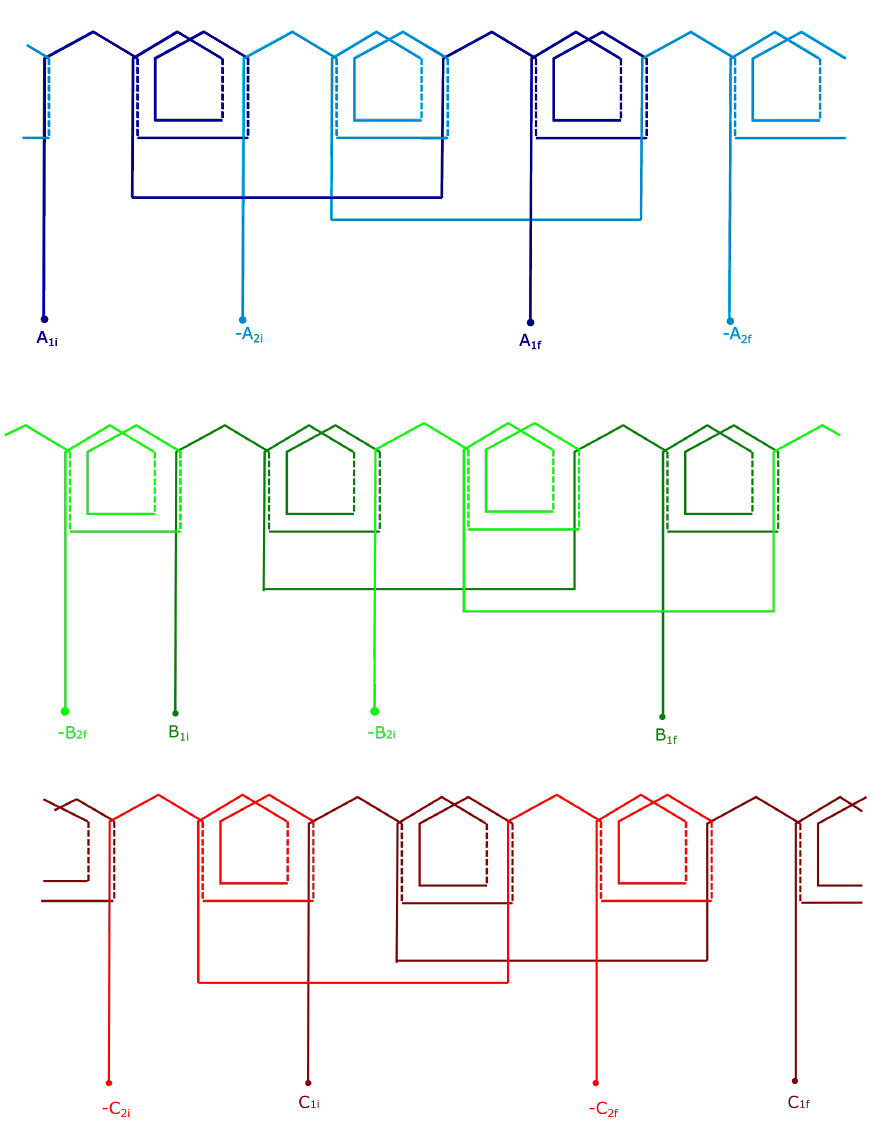
Figure 5. 4-pole winding connections. Figure 5. Four-pole winding connections. The total slot matrix for the winding, considering both inverter phase connections, is: